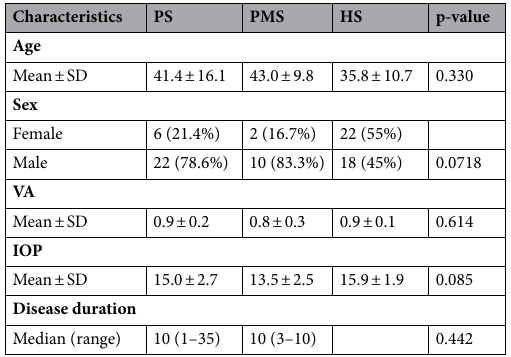
Table 1. Demographic and clinical data of psoriasis patients, metabolic syndrome and controls. PS psoraisis group, PMS psoraisis and metabolic syndrome, HS healthy control, VA visual acuity, IOP intraocular pressure.